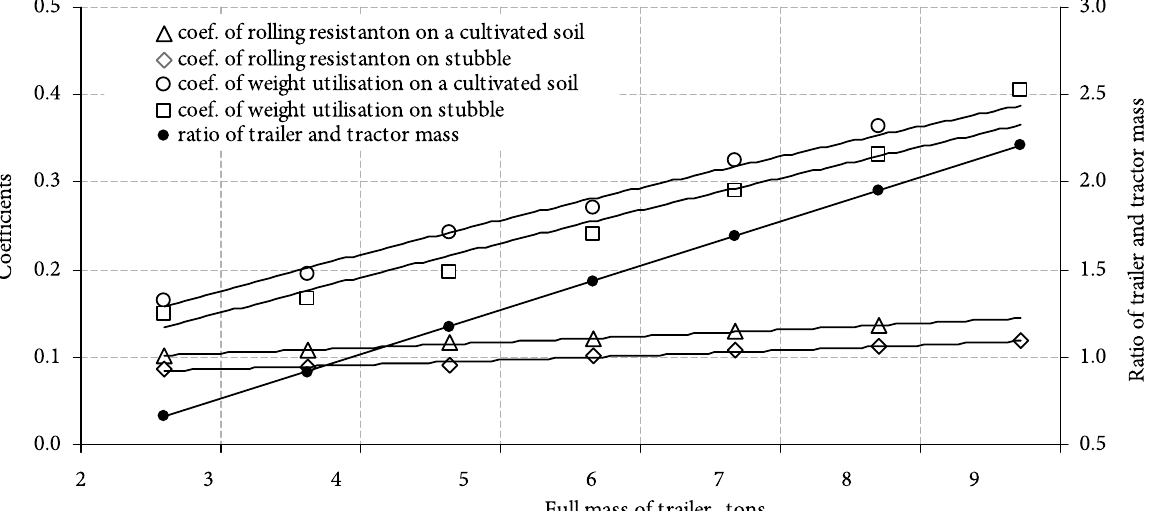
Fig. 4 . The dependence of the rate of traction features on the fully loaded trailer at a constant speed of the